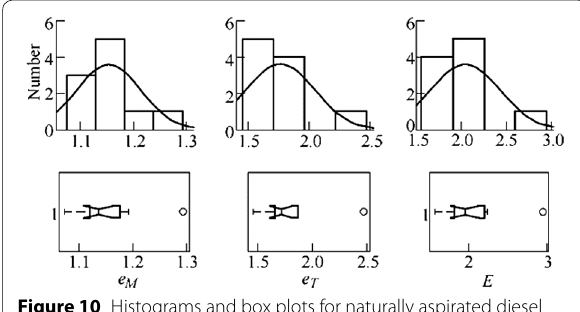
Table 11 Results of the calculations for turbocharged